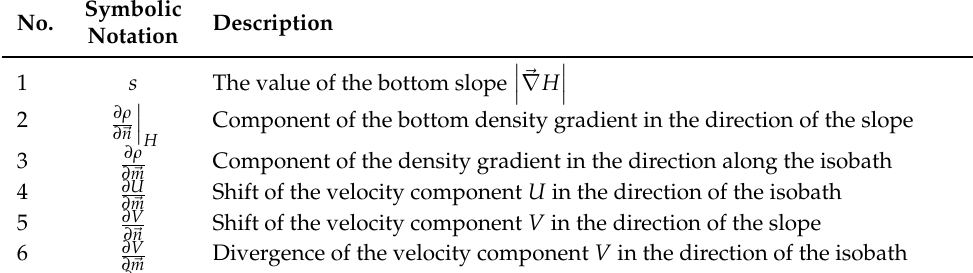
(cid:0) (cid:1) = (cid:126) ∇ H n x , n y is the direction of the slope, and (cid:126) m = | (cid:126) ∇ H |